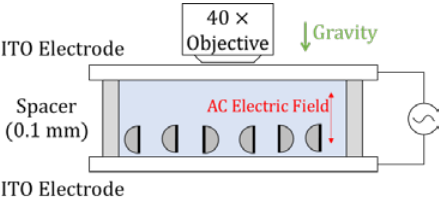
Figure 3. The suspension of the silver coated hemispherical Janus particles was sandwiched between two horizontal transparent Indium Tin Oxide (ITO) electrodes. The applied voltage was 10 V in amplitude at 1 kHz. Images were captured using a microscope and a camera.